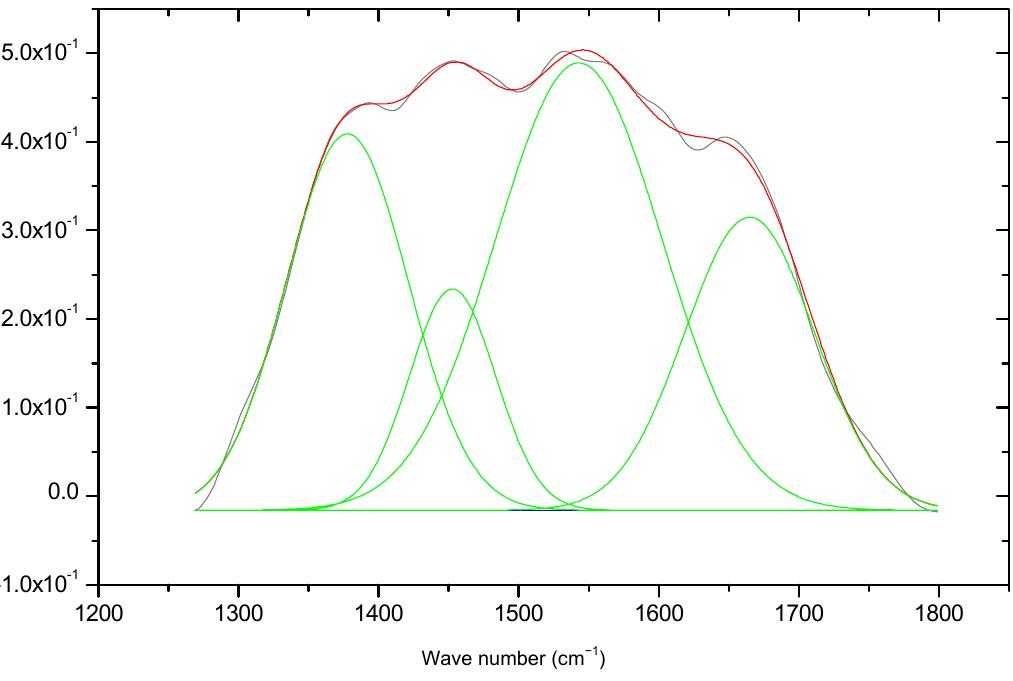
Figure 11. Deconvolution plot of carbonates zone FT-IR spectra of calcined